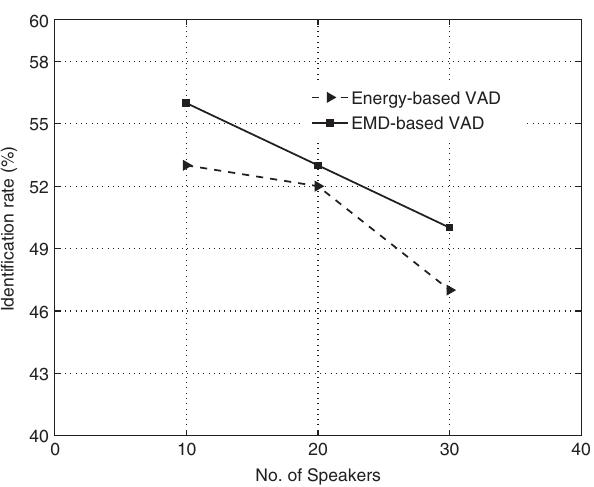
Figure 7. Performance Comparison of Energy-Based VAD and EMD-Based VAD in Terms of %IDR in a Text-Independent Language-Independent SI Scenario Under Realistic